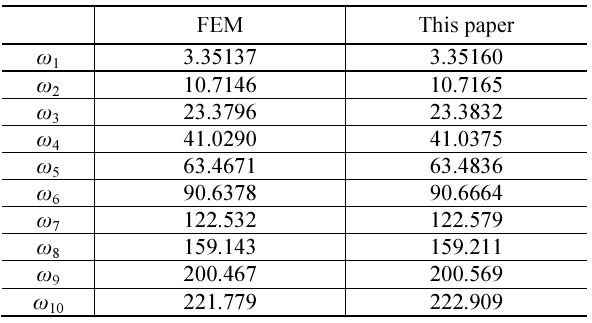
Table 1. Non-dimensional vibration frequencies 2